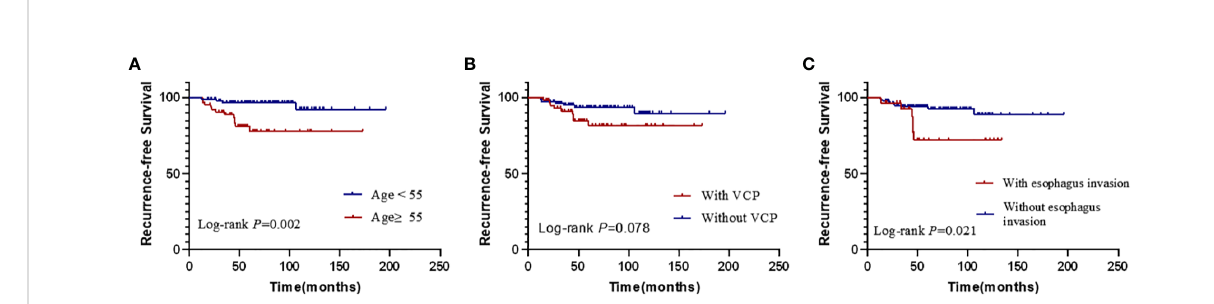
FIGURE 3 Kaplan – Meier curves for the recurrence-free survival according to different risk factors of univariable analysis. (A) the differences of RFS according to age (B) the differences of RFS according to the preoperative condition of the vocal cords. (C) the differences of RFS according to the status of esophagus. (VCP, vocal cord paralysis).